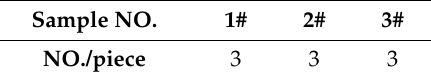
Figure 1. Flow chart of the test. Table 2. Number of